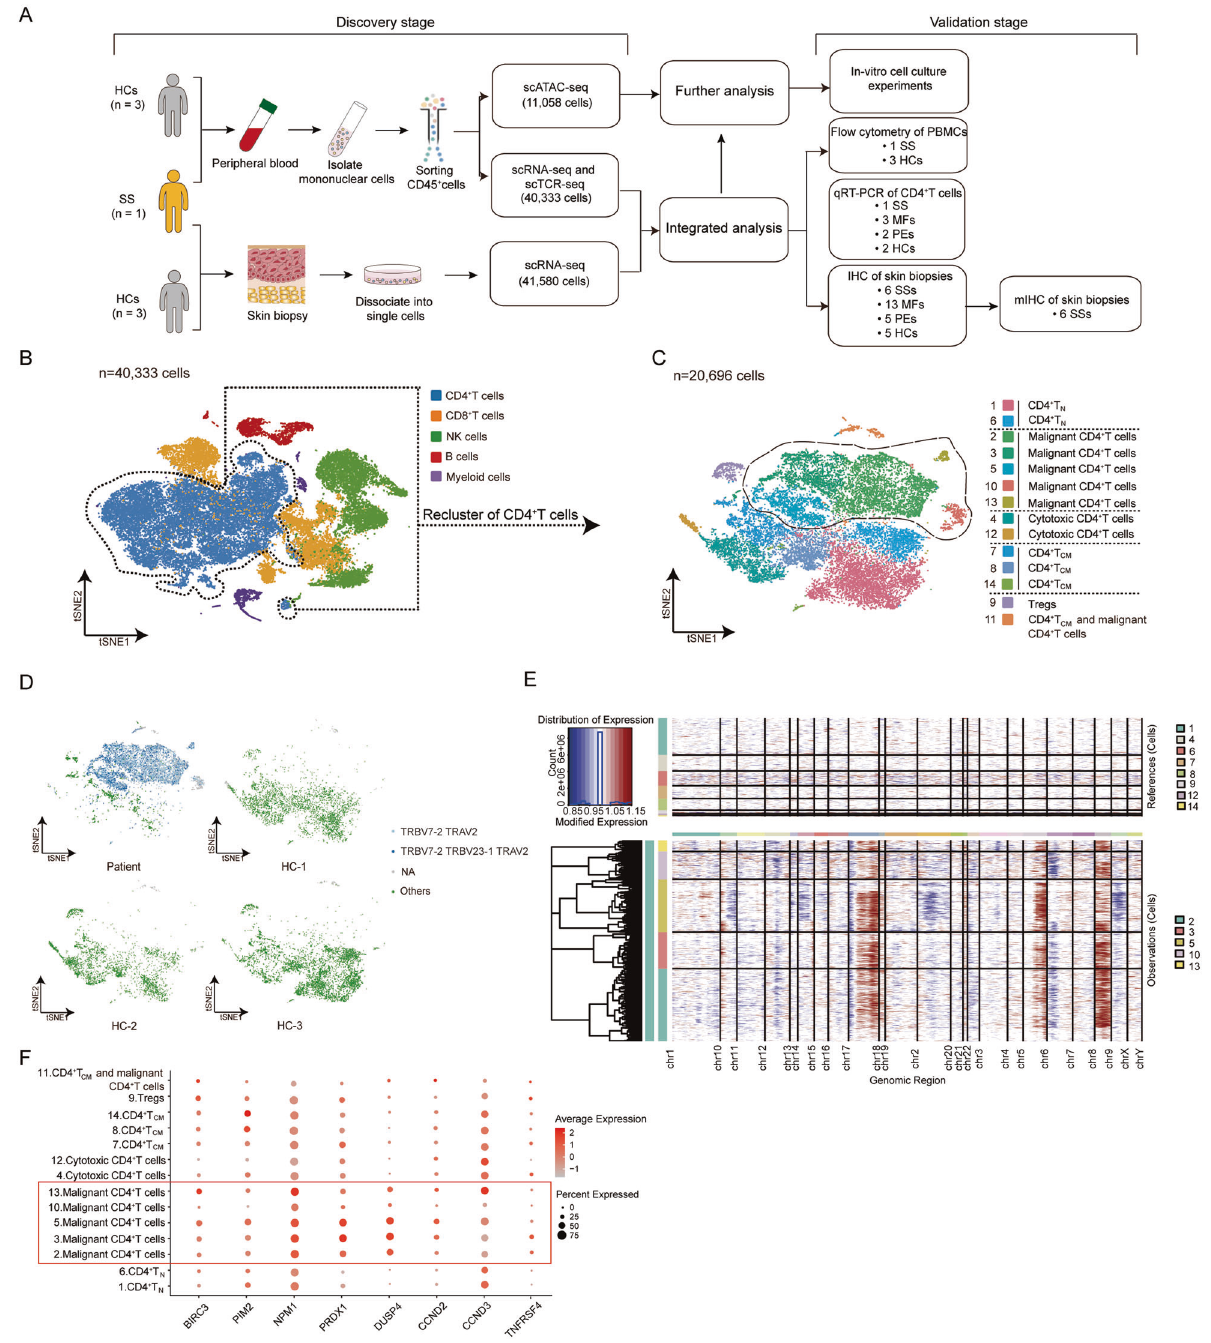
Fig. 1 Identi fi cation and transcriptional characteristics of malignant CD4 + T cells in PBMCs. A Overview of study design. B t-SNE visualization of PBMCs scRNA-seq pro fi le showing the formation of fi ve main clusters. C Sub-clustering of CD4 + T cells in PBMCs from the SS patient and HCs, showing the formation of 14 main clusters. D TCR analysis of PBMC CD4 + T cells from the SS patient and HCs. E CNV analysis of PBMC CD4 + T cells from the SS patient and HCs. F Dot plot showing the expression of selected cell-cycle, proliferation, and T-cell activation- associated genes in each cluster of PBMC CD4 + T cells from the SS patient and T RM phenotype with low proliferation compared to blood-derived SCs. Moreover, cell-cell interactions between malignant CD4 + T cells from PB and all cell types from skin showed that blood- derived malignant CD4 + T cells strongly communicated with vascular endothelial cells via chemokine ligand-receptor axes, such as CCL5-ACKR1 and ICAM1-AREG axes [29, 30] (Fig. 3H), further illuminating the mechanism of blood-derived neoplastic cell homing to the skin.